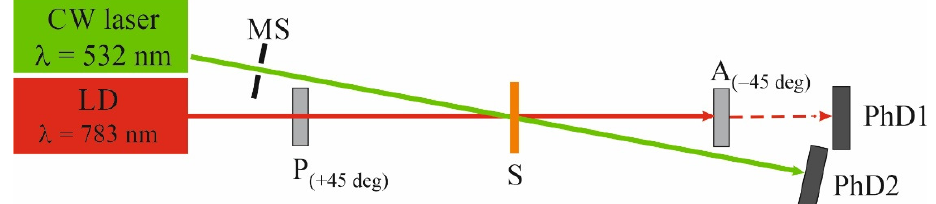
Figure 8. Photoinduced birefringence experimental setup at 532 nm: P—polarizer;